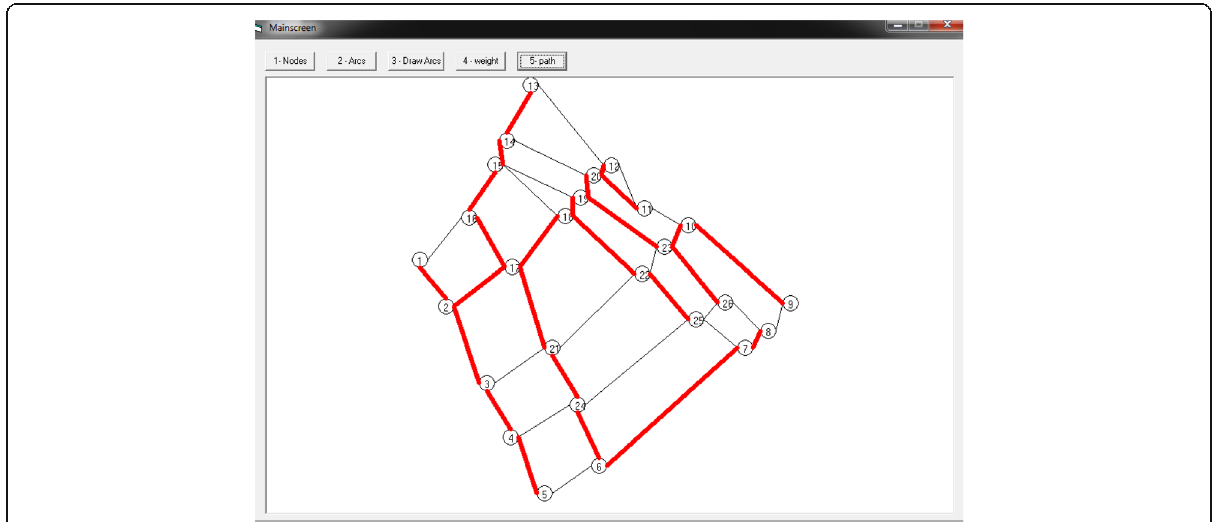
Fig. 20 The Results Derived from Implementing the Model of Transportation Constructions Index on the Sample Data using Software